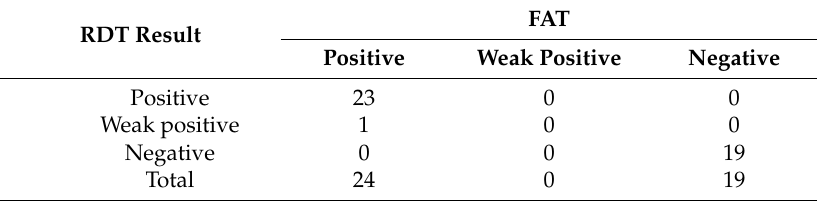
Table 2. Summary of results shown in Table 1 in a 2 × 2 table, for calculation of relative Sensitivity and Specificity of the rapid diagnostic test (RDT) using the fluorescent antibody test (FAT) as reference